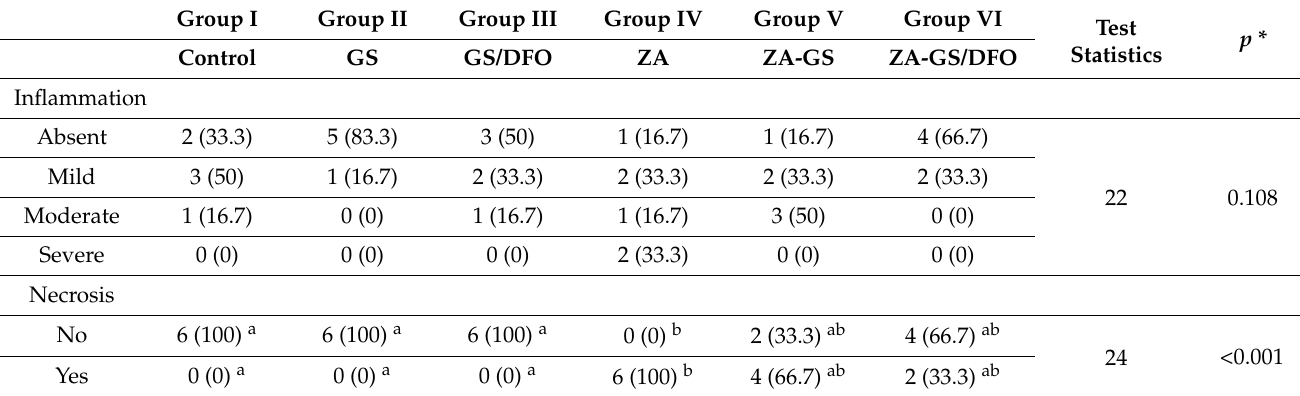
Table 2. Comparison of inflammation and necrosis by